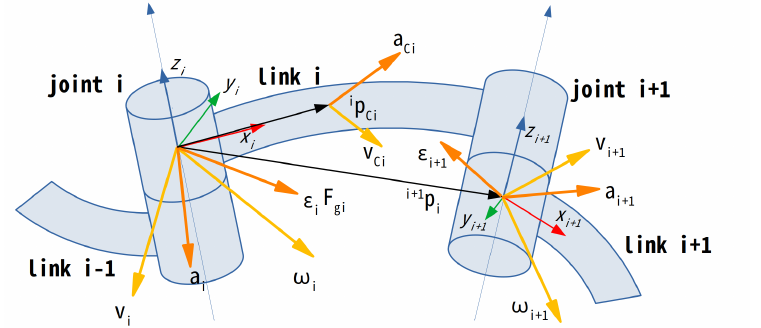
Figure 4. Kinematics link of the articulated